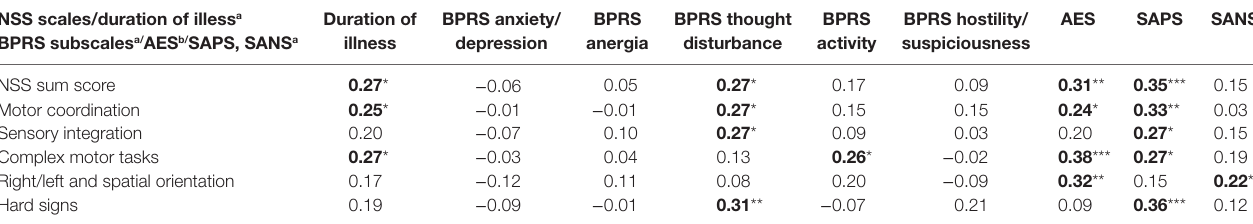
Table 3 | Correlations between neurological soft signs (NSS) scales and